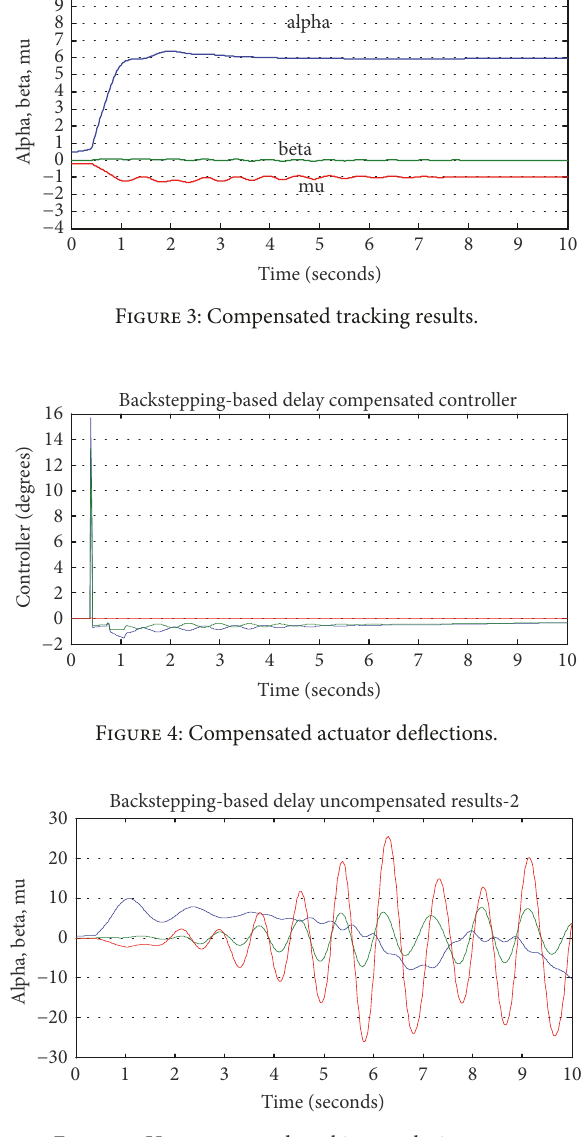
Figure 5: Uncompensated tracking results in